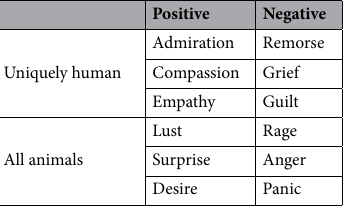
Table 1. Emotion terms included for each condition in Study